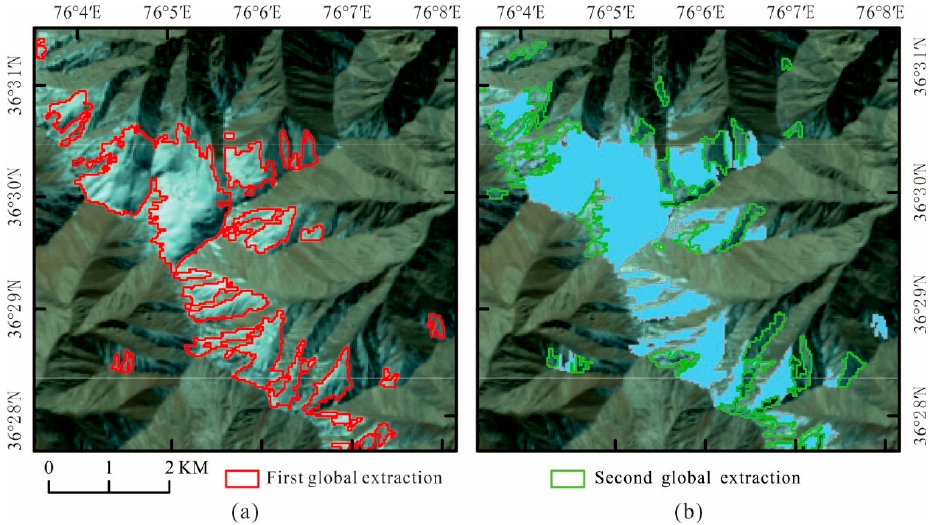
Figure 4. Global extraction based on objects, taking image LE71480352002285SGS00 as an example. ( a ) First global extraction, and ( b ) Second global extraction.